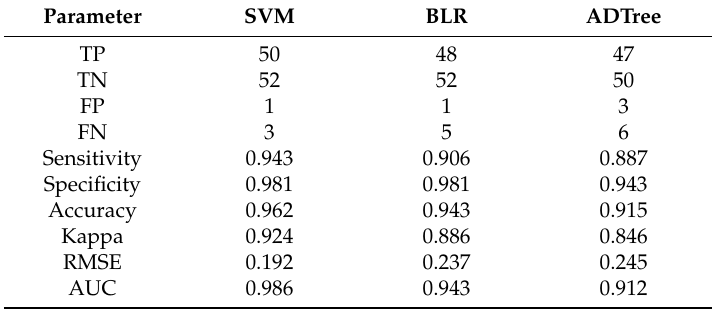
Table 4. Performances of the SVM, ADTree, and BLR algorithms on the training dataset.